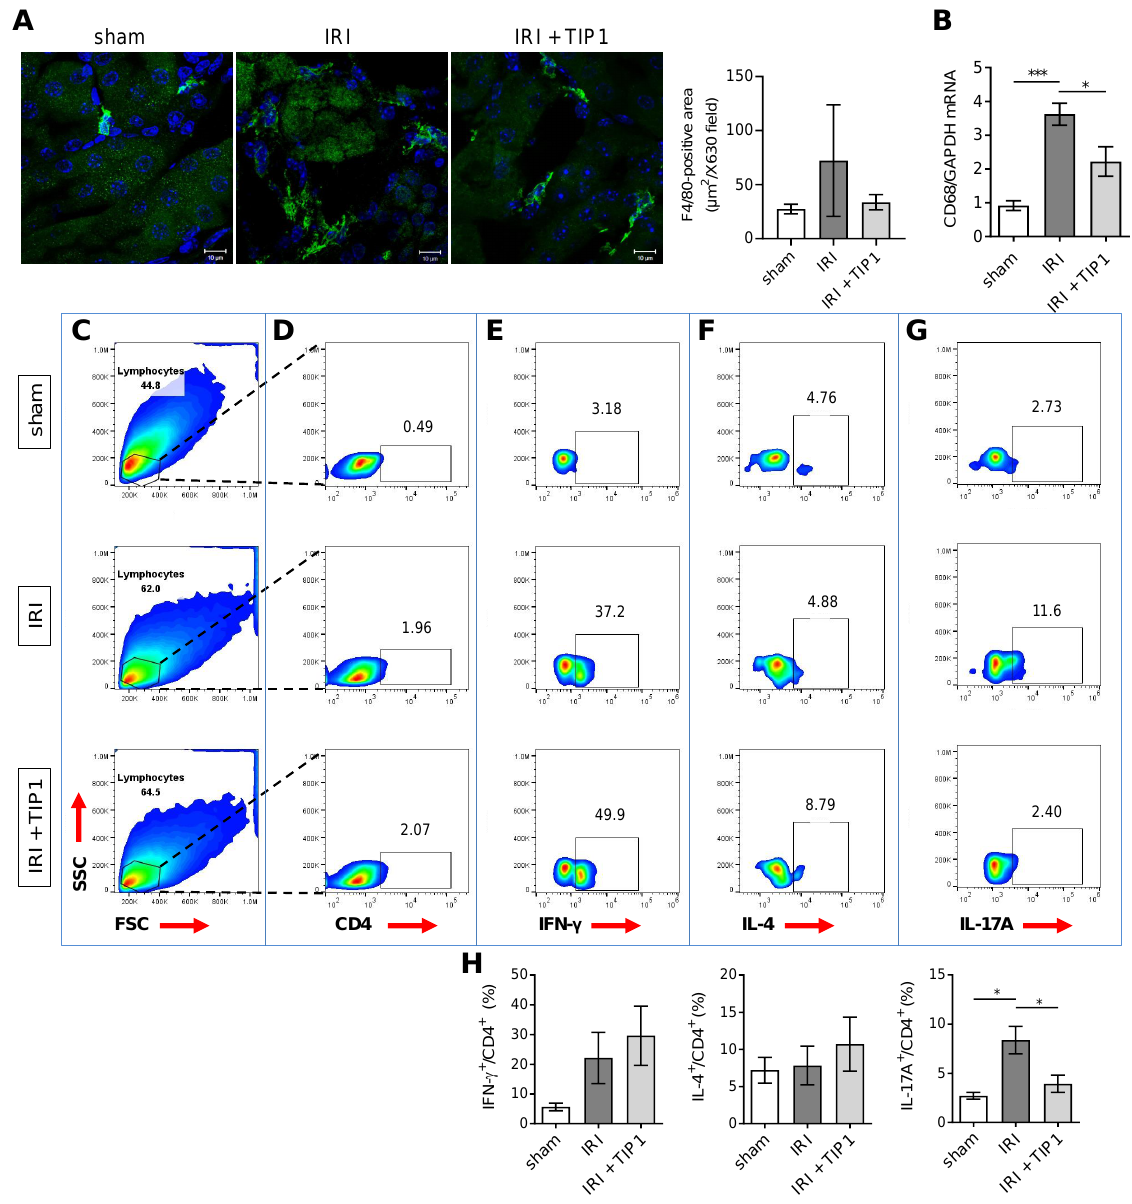
Figure 5. Inhibitory effect of TIP1 on immune cells following kidney ischemia-reperfusion injury. ( A ) Immunofluorescence staining and quantification of F4/80 + macrophages in the kidneys. Kidneys from sham ( n = 4), IRI ( n = 6), and IRI-TIP1 ( n = 6) groups were harvested 24 h after IRI. Nuclei were counterstained with DAPI (blue). Scale bar = 10 µ m. ( B ) CD68 mRNA expression in kidney tissue from sham ( n = 6), IRI ( n = 6), and IRI-TIP1 ( n = 6) groups. The intrarenal lymphocyte ( C ) and CD4 + cell populations ( D ) at 24 h after IRI. The intrarenal IFN- γ + /CD4 + ( E ), IL-4 + /CD4 + ( F ), and IL-17A + /CD4 + ( G ) cell populations at 24 h after IRI. ( H ) The percentage of intrarenal IFN- γ + , IL-4 + , and IL-17A + cell populations among CD4 + T cells. Kidneys from sham ( n = 4), IRI ( n = 6), and IRI-TIP1 ( n = 6) groups were harvested at 24 h after IRI. Data are pooled from two independent experiments and expressed as mean ± SEM. * p < 0.05, *** p < 0.001. TLR-inhibitory peptide 1 (TIP1); forward scatter (FSC); side scatter (SSC); interferon-gamma (IFN- γ ); interleukin-4 (IL-4); interleukin-17A (IL-17A); 4 (cid:48) ,6-diamidino-2-phenylindole